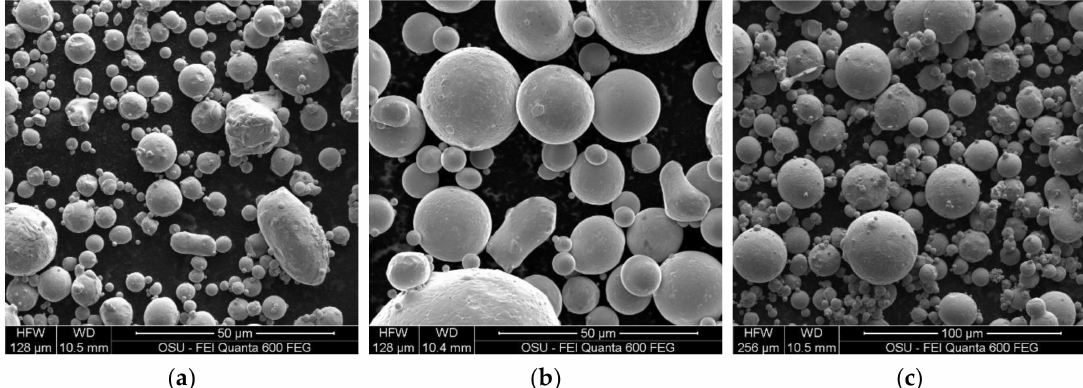
Figure 2. Scanning electron microscopy (SEM) micrographs of the powders used in the bimodal mixture, including ( a ) the smaller, USRN; ( b ) larger powder, GH; and ( c ) bimodally distributed powder, BIMO.